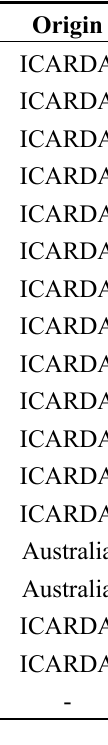
Table 6. Pedigree and origin of 35 introduced lentil genotypes used. ICARDA: International Center for Agricultural Research in Dry